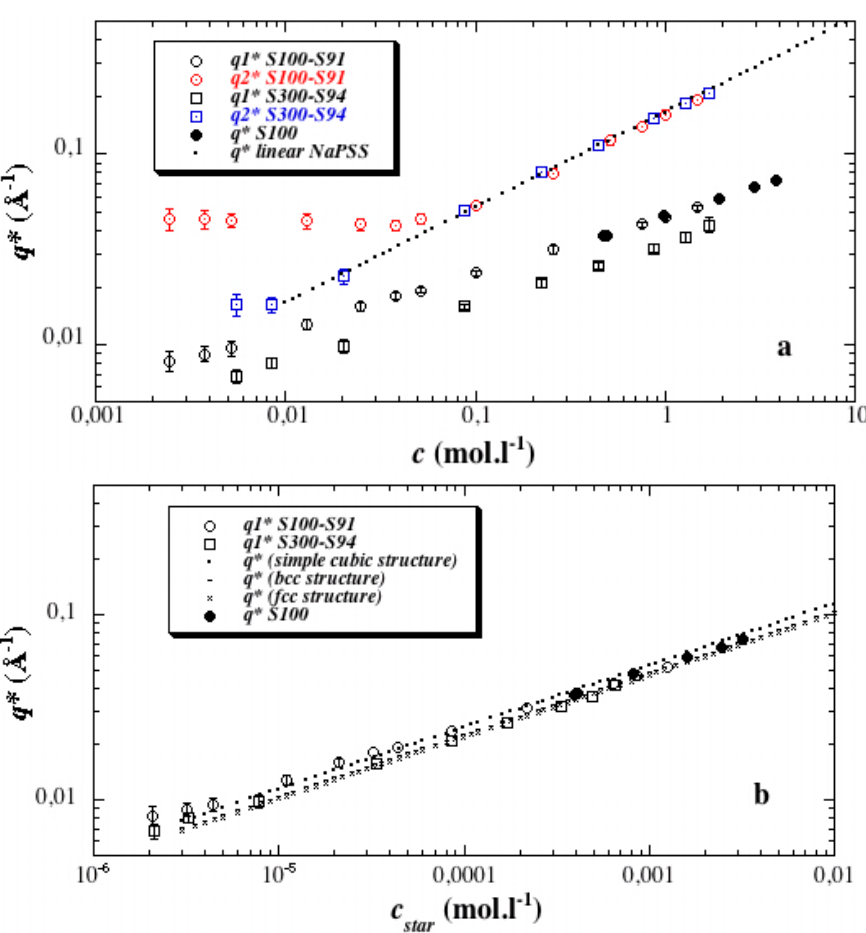
Figure 3. Indexation of the main maxima of the PS and NaPSS star scattering functions. ( a ) Scattering vectors q * (PS) [1], q 1 * and q 2 * (NaPSS) versus statistical unit concentration c . The scaling law associated with NaPSS linear polyelectrolytes of sulfonation degree close to one is also plotted ( q * = (0.165 ± 0.002) c 1/2 [18,20]); ( b ) q * (PS) [1], q 1 * (NaPSS) versus star concentration c star (not to be confused with c *). The expected scaling laws for a simple cubic lattice (. . .), a body-centered cubic (bcc)-lattice (- - -) and a face-centered cubic (fcc)-lattice (× × ×).